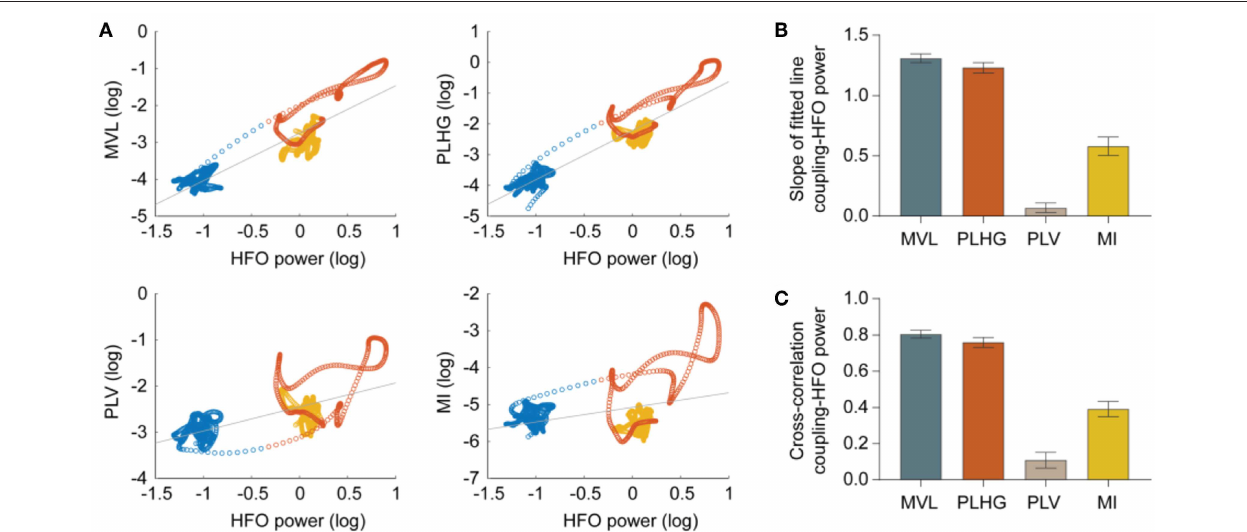
FIGURE 4 | Correlation between phase-locked HFO measures and HFO power. (A) Scatter plots show relations between measures and HFO power during preictal (blue circles), ictal (red), and postictal (yellow) periods for a representative seizure and channel. Each circle represents values obtained from a 3-s moving window with 333ms moving step. The gray line is the fitted to the samples. (B) Quantification of slope of the fitted lines in the scatter plots, estimated from all channels of 32 seizures (MVL = 1.31 ± 0.03; PLHG = 1.23 ± 0.04; PLV = 0.07 ± 0.04; MI = 0.58 ± 0.07; n = 2,034 channels). (C) Normalized cross-correlation between the coupling measures and HFO power (MVL = 0.80 ± 0.02; PLHG = 0.76 ± 0.03; PLV = 0.11 ± 0.04; MI = 0.39 ± 0.04; n = 2,034 channels). Both the slope and cross-correlation analyses indicate that the MVL and PLHG measures are highly biased toward HFO power. Error bars indicate mean ± standard error